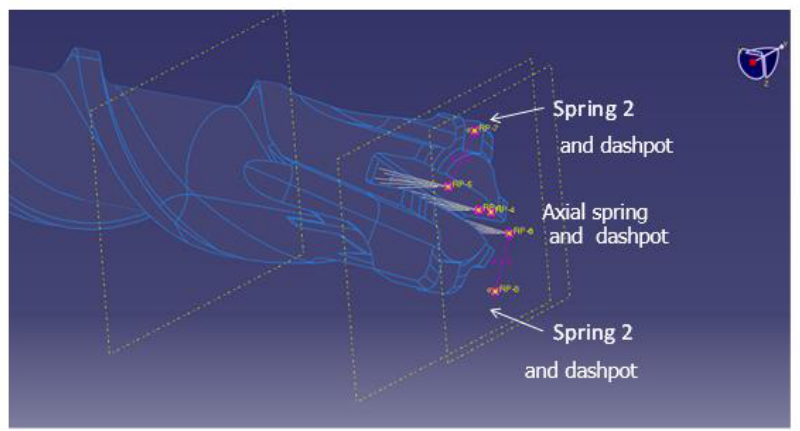
Figure 4. Inclined stiffnesses and dashpots to model the coupling between axial and torsional vi- brations.